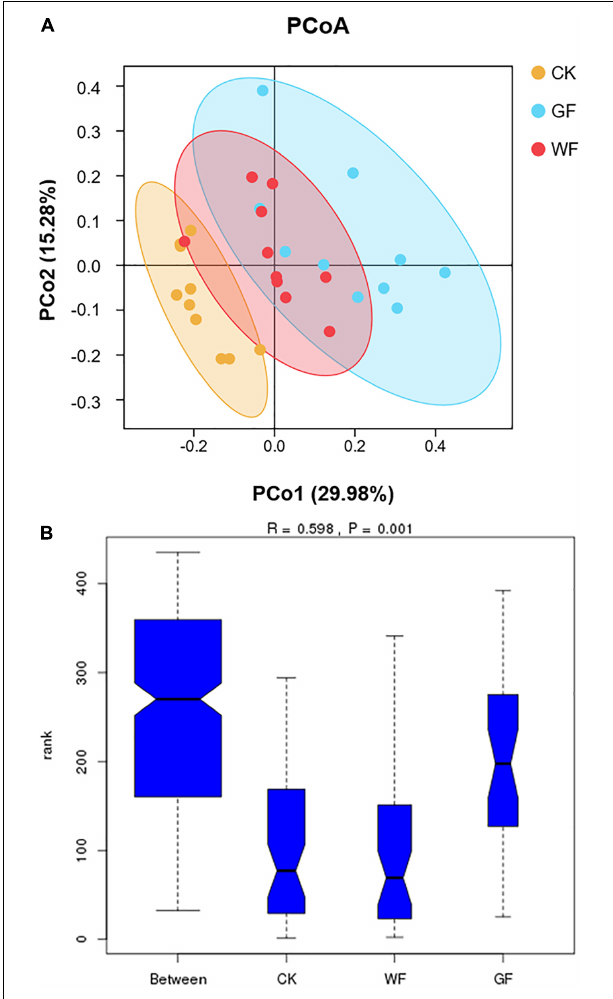
FIGURE 2 | (A) Principal coordinate analysis of rumen bacterial samples; (B) similarity of bacterial genera among the three groups. CK, dairy cows fed with control check diet (without flaxseed); WF, dairy cows fed with whole flaxseed diet (whole flaxseed 1,500 g per day); GF, dairy cows fed with ground flaxseed diet (ground flaxseed 1,500 g per